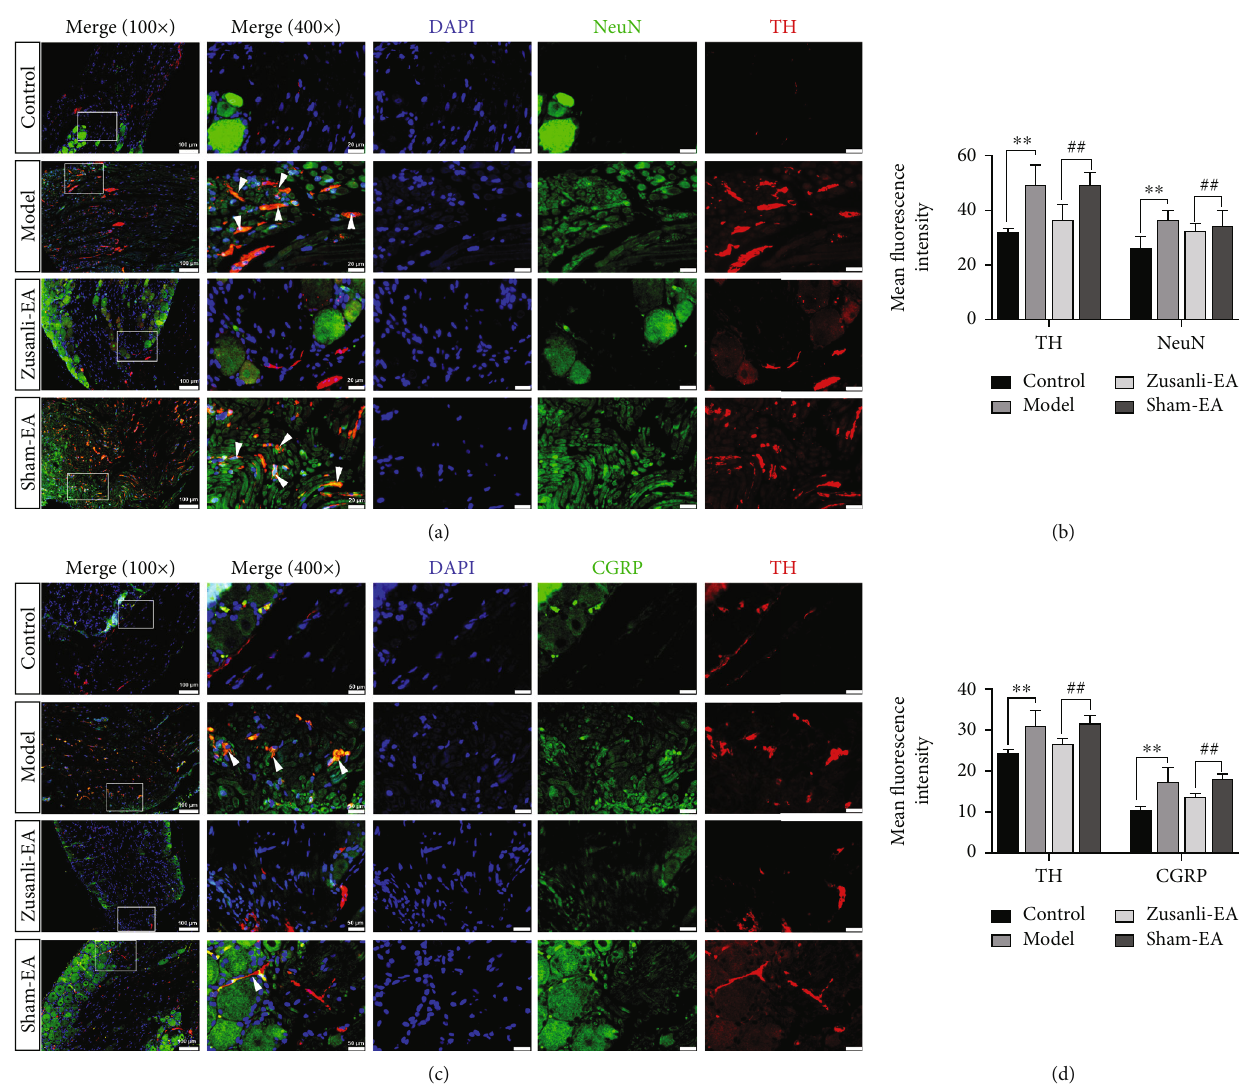
Figure 3: EA attenuated sympathetic-sensory coupling of L6 DRG in DSS-induced colitis rats. (a) TH/NeuN/DAPI immuno fl uorescence (IF) stain in the L6 DRG. Blue labeling is for DAPI, green labeling is for NeuN, and a red one for TH. (b) Quantitative immuno fl uorescence (IF) analysis. (c) Immuno fl uorescence (IF) stain for TH (green), CGRP (red), and DAPI (blue) and colocalization of TH and CGRP in the L6 DRG. (d) Quanti fi cation of TH and CGRP immuno fl uorescence (IF). ∗∗ P < 0 : 01 vs. control group, ## P < 0 : 01 vs. sham-EA group. Data represents means ± SD